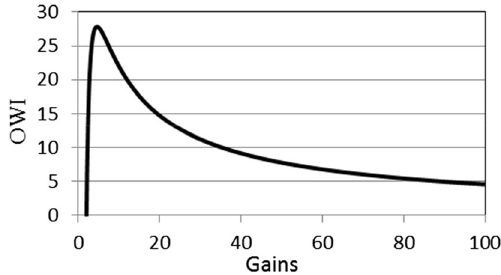
Fig. 1 Plot of F p = 50%, C = 1, B = 1. max versus gains for the case Fig. 3 Plot of OWI (in %) from the Cozzolino formula (“Appen- Note that F max tends to the limit of p (= 50%) as the gains rise indefi- dix 1”, Eq. 9) versus gains for the case p = 50%, C = 1, RT = 1. Note nitely how the OWI decreases at high gains